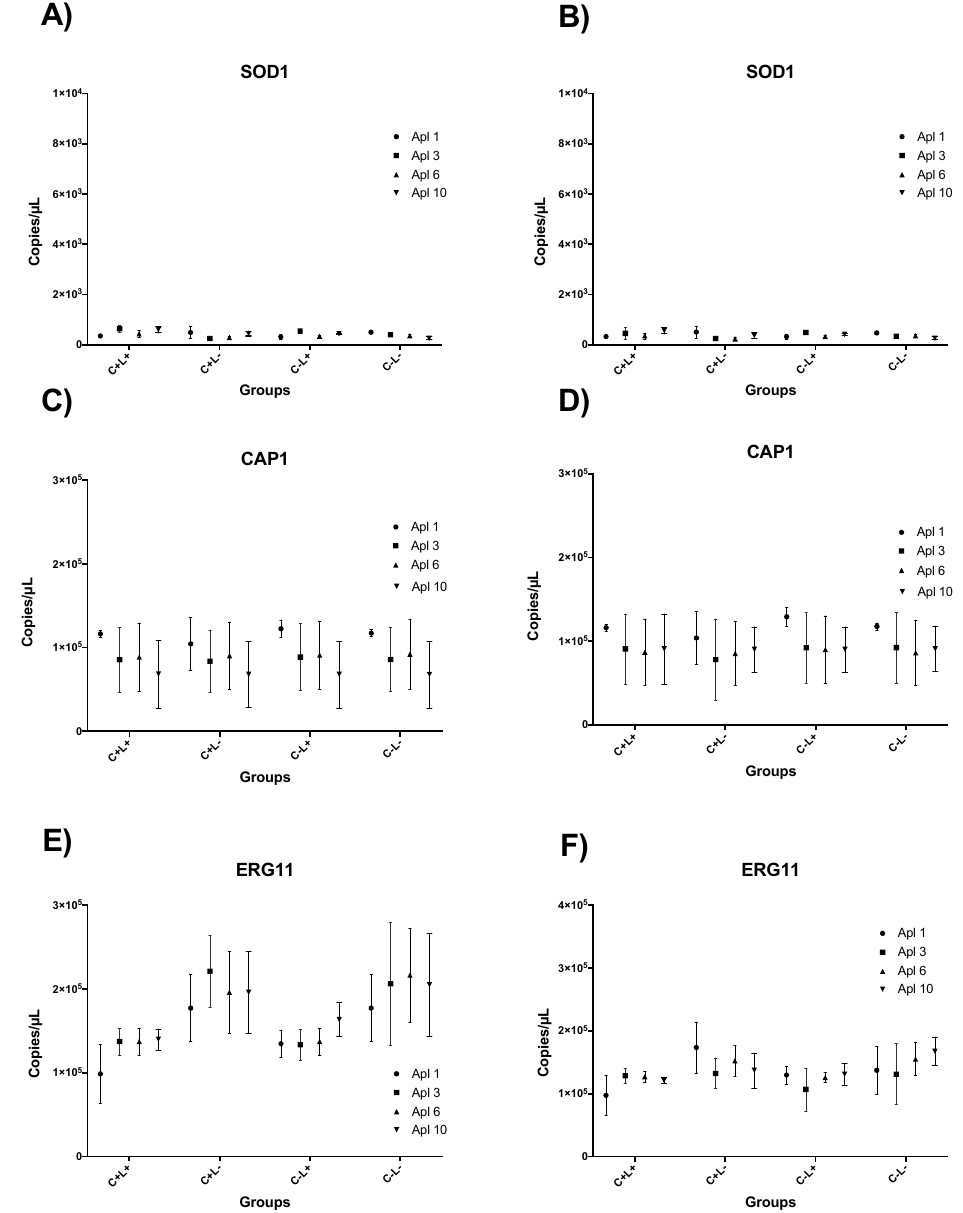
Figure 13. Graphic representation of mean ± confidence interval of 95% of SOD1 ( A , B ), CAP1 ( C , D ), and ERG11 ( E , F ) gene expression in each experimental group of C. albicans cells removed from biofilm cultured in SDA without ( A , C , E ) and with ( B , D , F ) fluconazole after first (Apl#1), third (Apl#3), sixth (Apl#6) and tenth (Apl #10) application of CUR-mediated aPDT (C+L+), FS control (C+L − ), light control (C − L+), and experiment control group (C − L − ). Minimum and maximum values of the copies/ µ L error bar represent the lower and upper limits of the confidence interval, respectively. The non-intersection of error bars denotes statistical difference ( p < 0.05). For the ERG11 gene (Figure 13E), Apl#1 of the C+L+ group was statistically different from the C − L − group, with a reduction of 2.87 × 10 5 copies/ µ L when cells were grown on SDA plates without fluconazole. However, in cells grown on SDA with